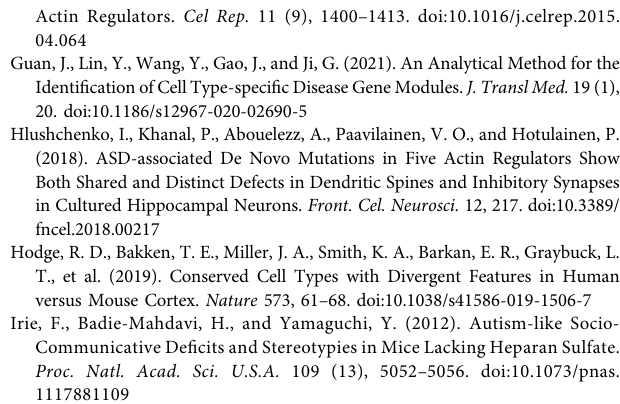
Supplementary Table S1 | Shared and cell-type-speci fi c ASD-associated gene modules. For these modules, their Bonferroni-adjusted hypergeometric p -values, module genes sorted by z-scores, and enriched gene functions are listed. Supplementary Table S2 | Shared and cell-type-speci fi c ASD-associated gene modules that have module-speci fi c gene functions. For these modules, their Bonferroni-adjusted hypergeometric p -values, module genes sorted by z-scores, and enriched module-speci fi c gene functions are